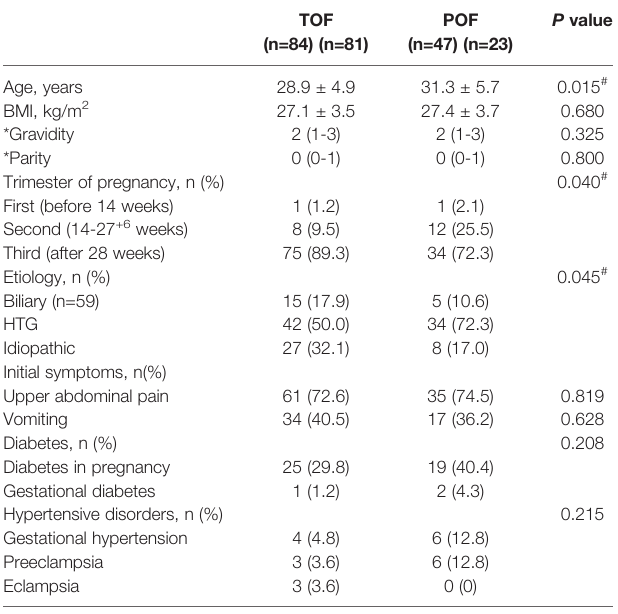
TABLE 1 | Characteristics of APIP patients between POF and TOF groups.